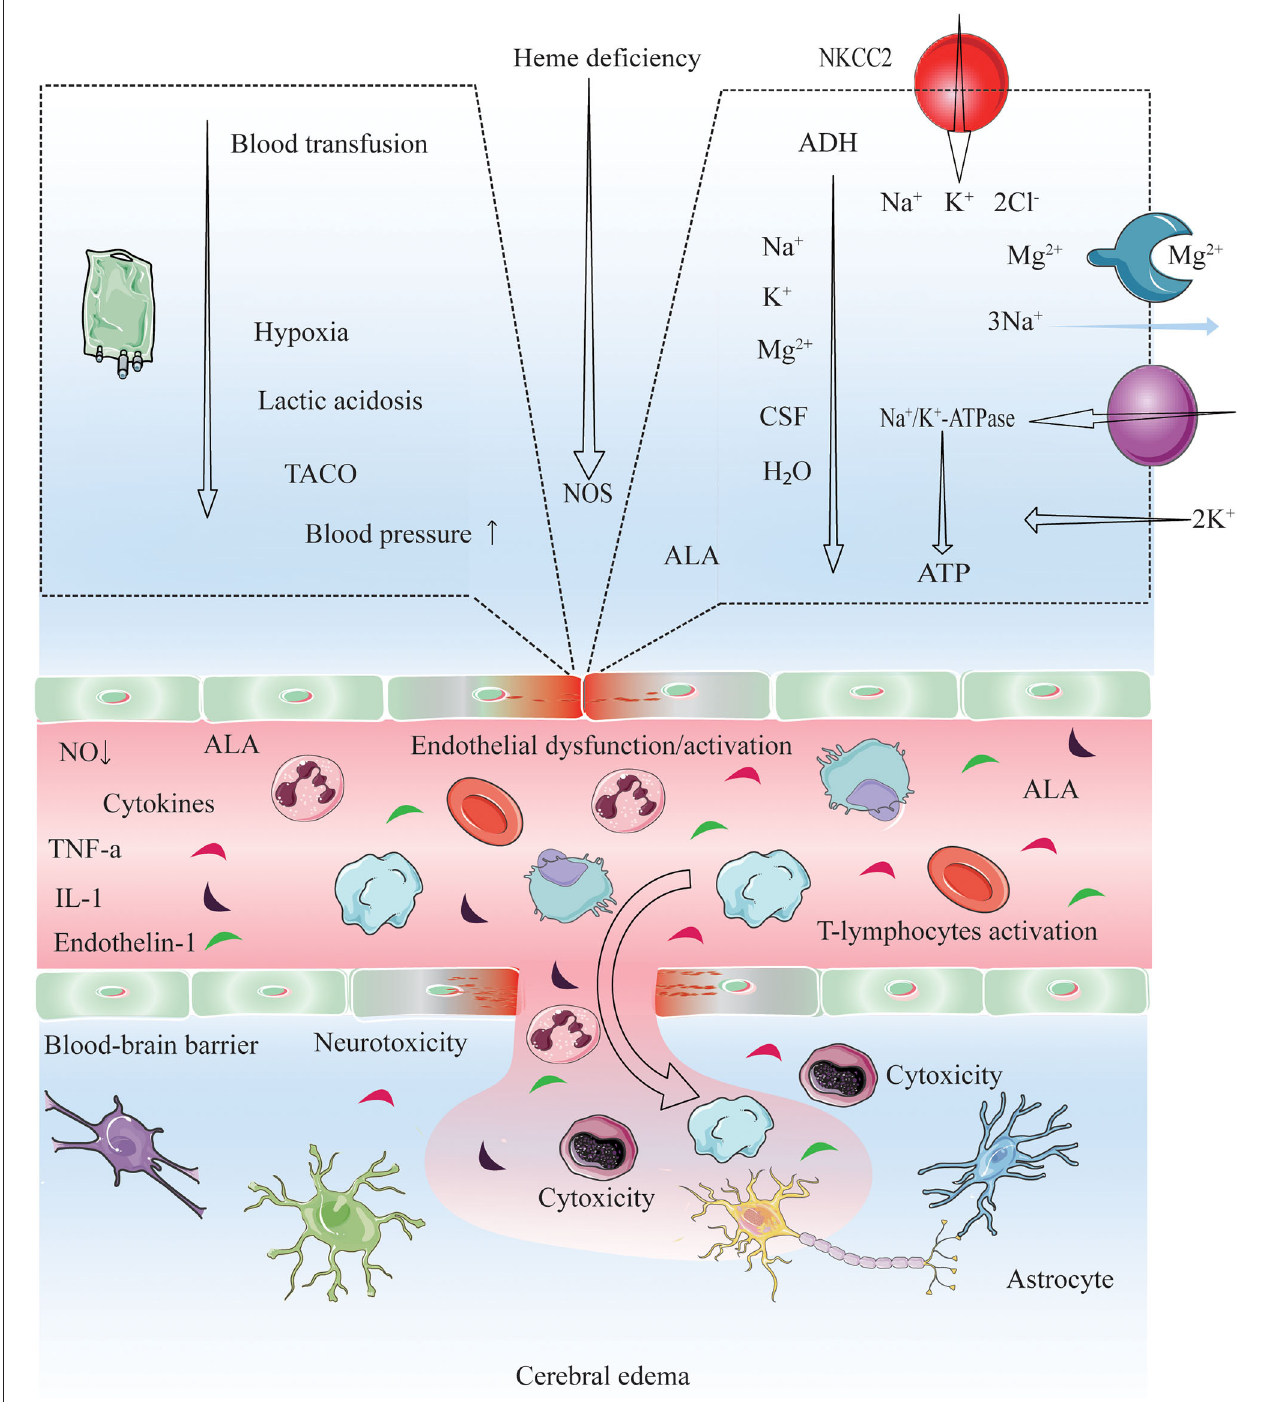
FIGURE 4 | Proposed pathogenic model for cerebral edema and CNS dysfunction after conducting chemotherapy, HSCT and immunosuppressive agents. Endothelial wall inflammation disrupts the tight junctions and increase the permeability of the BBB due to high levels of circulating cytokines (TNF- α , IL-1, endothelin-1) and activating leucocytes (autoreactive T-cells). Consequently, enhanced fluid and cell diapedesis, and interstitial edema formation ensues. PRES manifestation and the dysfunction of microvasculature may be driven by the presence of checkpoint inhibitors (HSCT, chemotherapy, and immunosuppressive agent), by interactions with autoantibodies and autoreactive T-cells, and via abnormal secretion of angiogenic growth factors (VEGF) and proangiogenic cytokines (IL-8) (33, 66, 67), VEGF expression is increased, leading to increased vascular permeability and interstitial cerebral edema (33). Blood transfusion triggers a rapid increase in the hemoglobin,